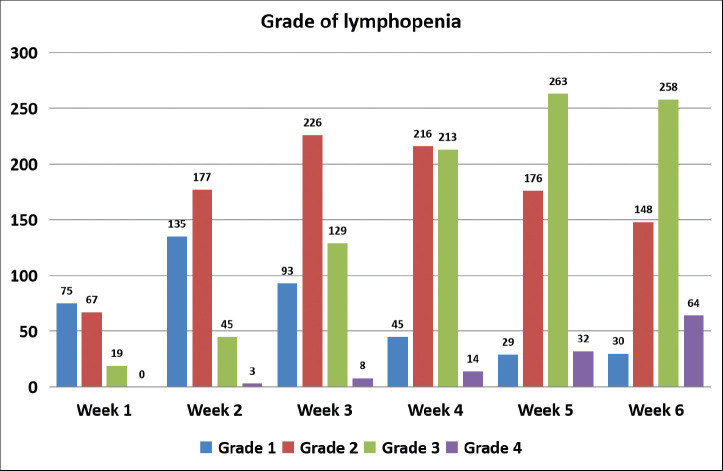
Week-wise incidence and grading of lymphopenia.